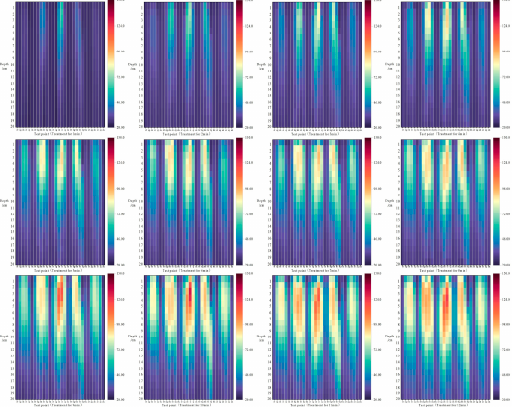
Figure 17. Heatmap of the internal temperature of 10% black soil under microwave irradiation.